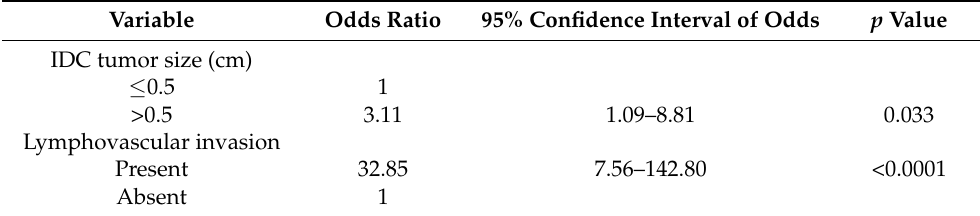
Table 4. Multivariate analysis of factors influencing the lymph node status in underestimated invasive breast carcinoma patients with initial diagnosis of ductal carcinoma in situ by image-guided core needle biopsy.